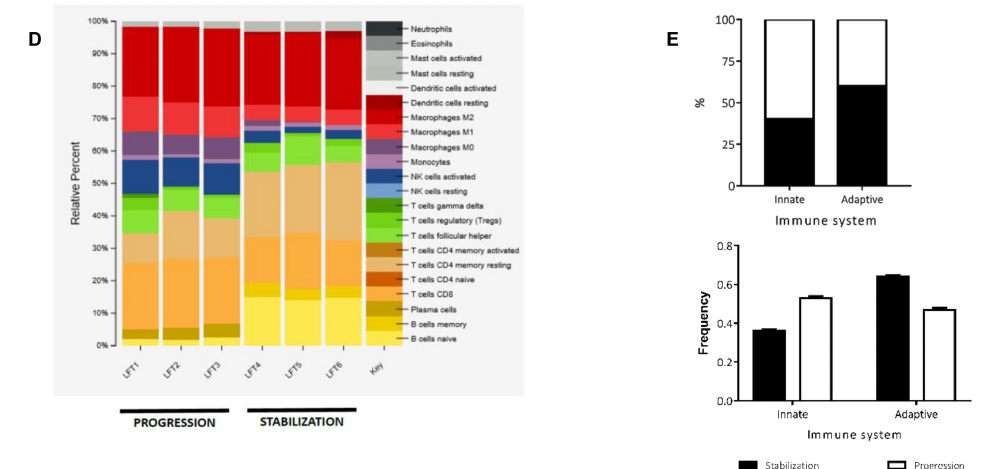
Figure 1. Immune cell estimation in tumor samples. ( A ) ESTIMATE (Estimation of STromal and Immune cells in MAlignant Tumor tissues using Expression data) graphs showed significant higher values of immune cells ( p = 0.0025) were found in stabilized disease compared to progression, whereas no significant di ff erences in stromal component were found between both samples ( p = 0.061). ( B ) Immunophenoscore also showed higher number of immune cells during stabilization. ( C ) MCPcounter graphs showed the abundance of distinct immune subpopulations in both tumor samples. ( D ) CIBERSORT showed the proportions of distinct immune cell subpopulations. ( E ) Graphs of the main immune component of each sample.